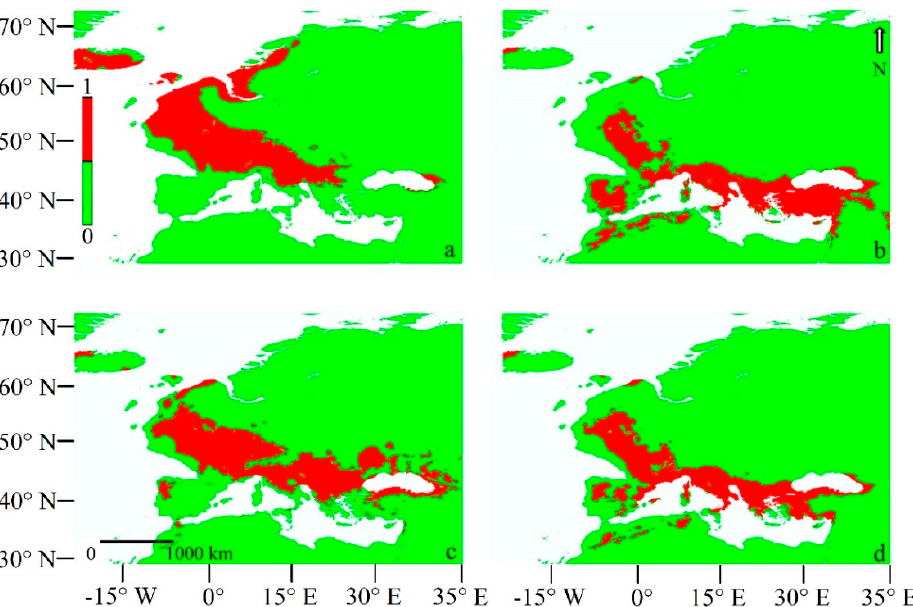
Figure 6. Ecological Niche Models for P. mugo/uncinata ( a ), P. nigra ( b ), P. sylvestris ( c ) and Q. pubescens ( d ) using the Last Glacial Maximum scenario. Binary map shows: 0 = unsuitable habitat; 1 = suitable habitat.